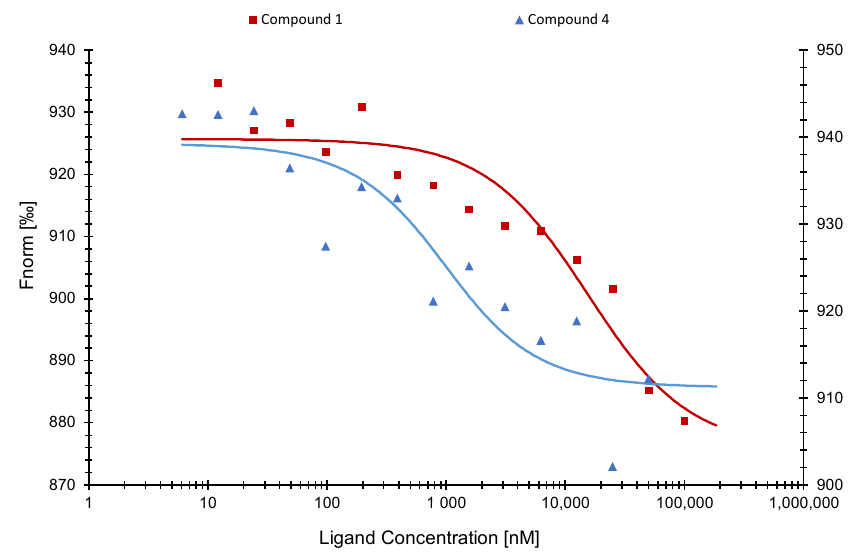
Figure 6. Binding curves of the SARS-CoV-1 NP NTD with compounds ( 1 ) ( left axis ) and ( 4 ) ( right axis ) as determined by microscale thermophoresis.